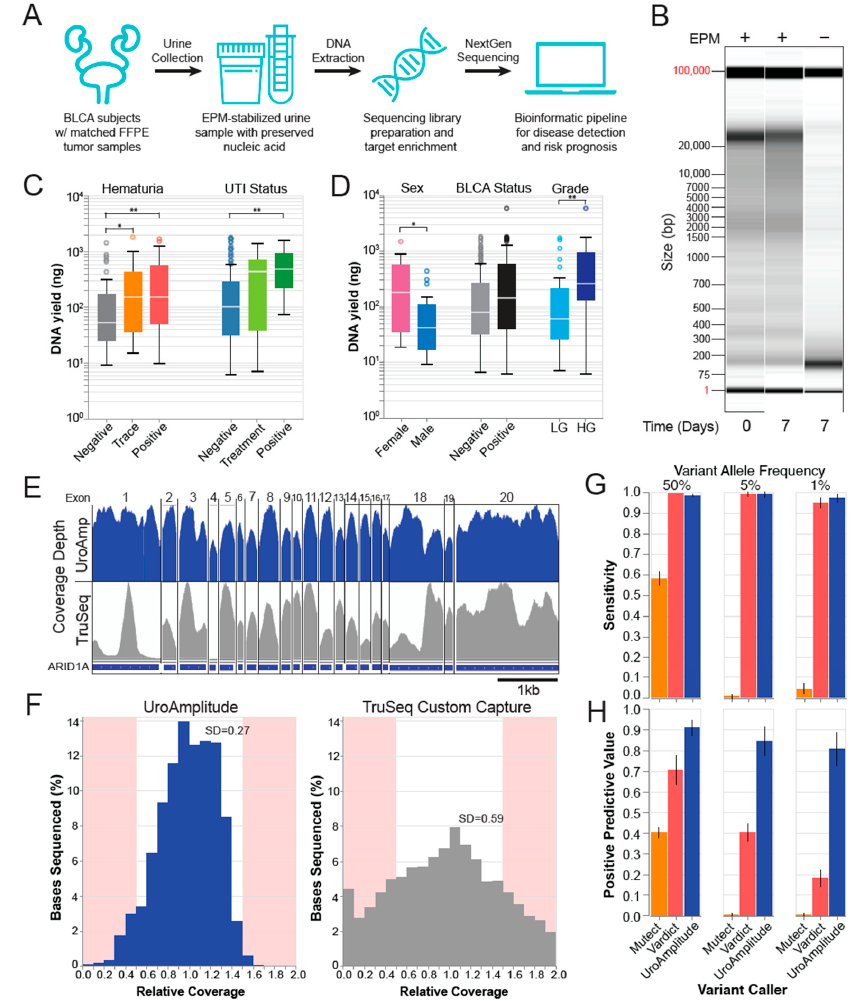
Figure 1. UroAmplitude workflow schematic and technical validation. ( A ) Urine samples are preserved in EPM at collection and shipped to Convergent Genomics laboratories where samples undergo automation-assisted DNA extraction, library preparation, target enrichment, and NextGen sequencing. A custom bioinformatics pipeline detects SNVs and CNVs and predicts disease status and risk. ( B ) Fragment Analyzer (FA) “gel view” of urine DNA purified immediately or after 7 days of RT incubation unbuffered or EPM stabilized. ( C , D ) Box plots of median extraction yields from 4ml urine aliquots for key urology clinic demographics: sex ( n = 21), disease status ( n = 272) and grade ( n = 73), hematuria status ( n = 92), and urinary tract infection (UTI) status ( n = 139).* p < 0.05, ** p < 0.01. ( E ) Representative IGV tracks of gene-level sequencing coverage following UroAmplitude or Illumina TruSeq capture. ( F ) Relative coverage (coverage at one location normalized to the median coverage across all locations) distributions for UroAmplitude and Illumina TruSeq hybrid capture methodologies. Sites outside 50% variance are highlighted. ( G , H ) Blinded, independent validation of technical sensitivity and Positive Predictive Value (PPV) for simulated somatic variants with heterozygous Variant Allele Frequencies (VAF) of 50%, 5%, and 1%. Three different variant callers are compared (MuTect, Vardict, and